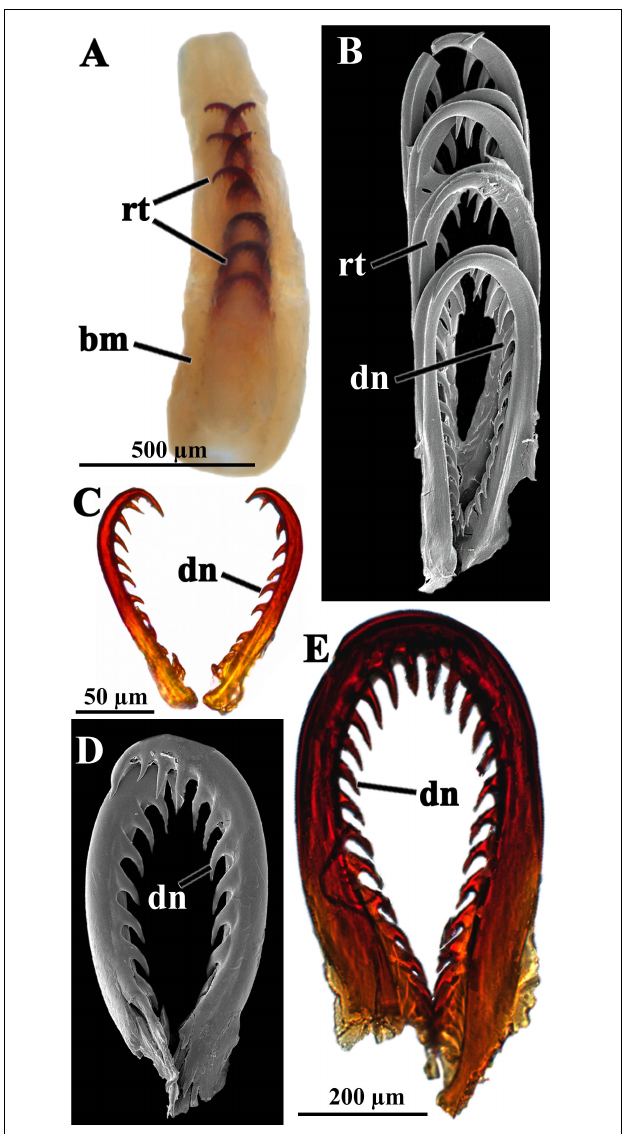
FIGURE 4 | Scutopus variabilis sp. nov. Photomicrographs under stereomicroscope (A) , SEM [ (B) and (D) ] and light microscopy [ (C) and (E) ] of the radula. In (A) (ZUEC APL 284) the entire radula of the individual shown in the Figure 1D is viewed immersed in the buccal mass. In (B) (ZUEC APL 319) four pairs of radular teeth are viewed in detail, and isolated pairs in (C–E) ; in (C) (ZUEC APL 321) and (D) (ZUEC APL 319) the teeth were obtained from two small specimens (up to 4 mm in length), and in (E) (ZUEC APL 285) from the larger animal (about 11 mm) shown in Figure 1 (B) . (B–D) are in